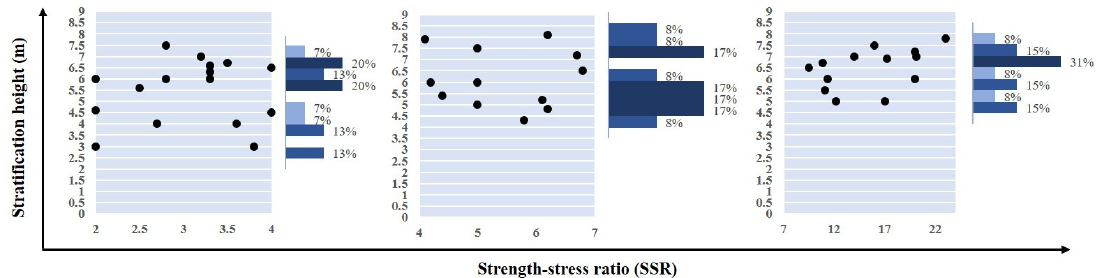
Figure 24. The dominant distribution of stratification height under different SSR at the high side wall zone.